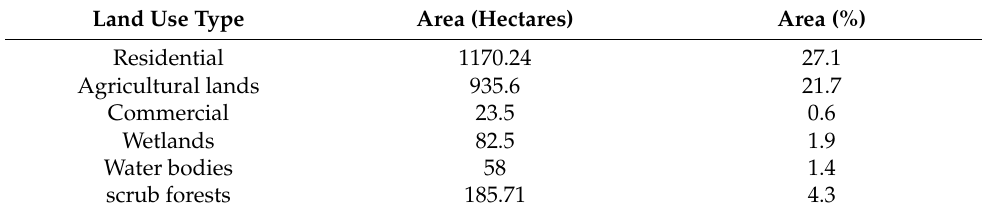
Table 2. Major land use categories in Batticaloa Municipality. Land Use Type Area